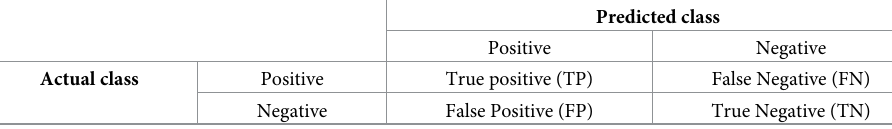
Table 1. Confusion matrix for a binary outcome (adapted from Fawcett